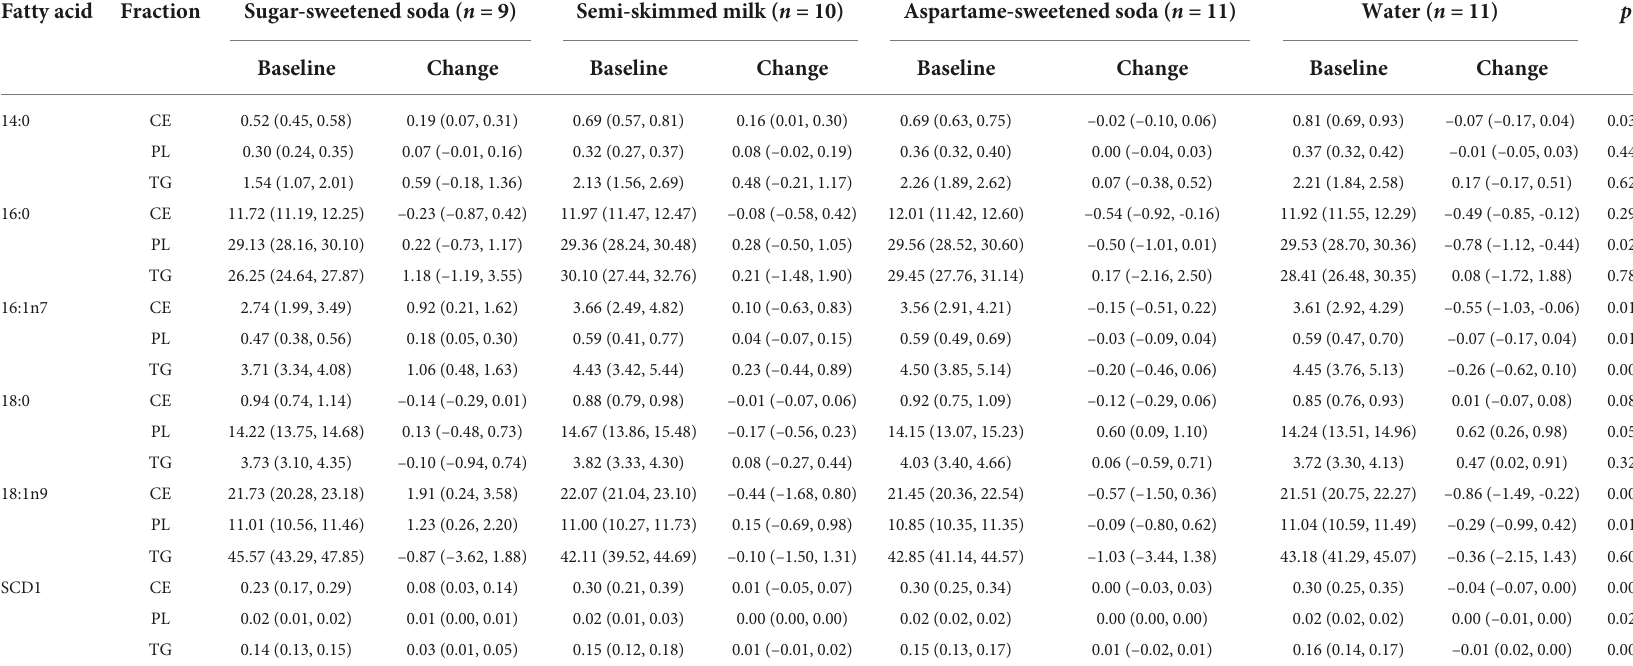
TABLE 3 Changes in plasma of fatty acids in different lipid